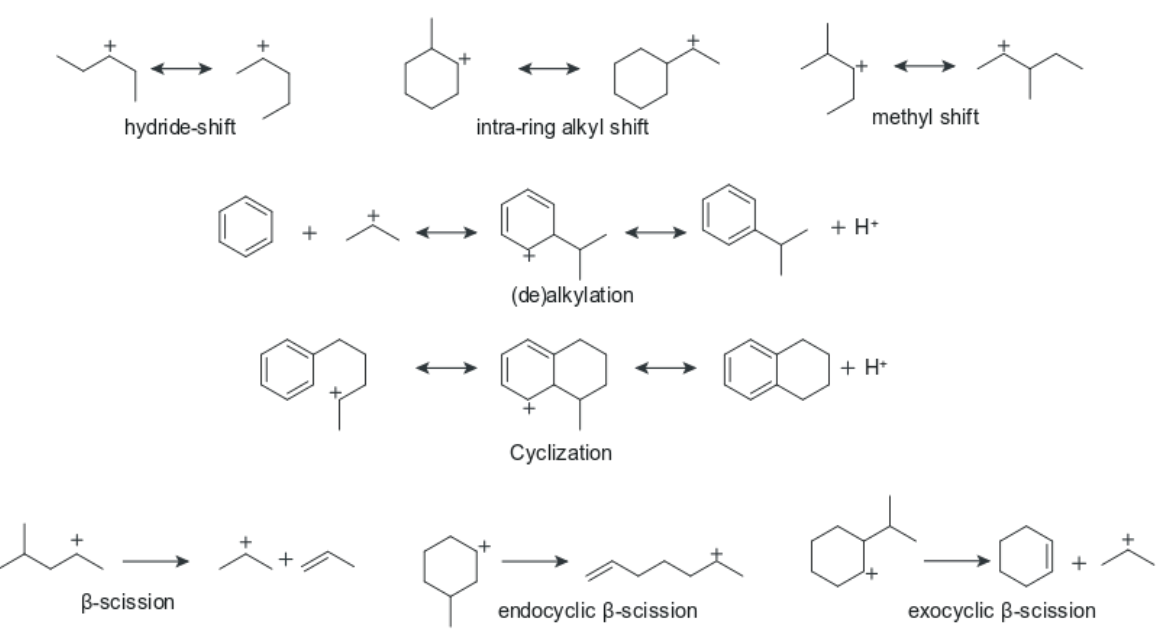
Figure 5. Some elementary steps of paraffins, olefins, naphthenes and aromatics in the FCC riser. (Adapted from